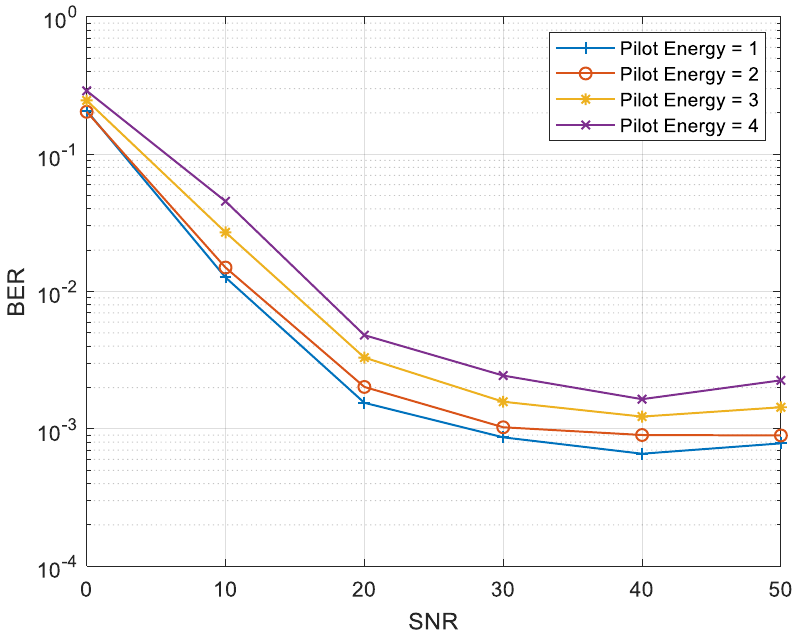
Figure 5. BER as a function of the pilot energies for CP-OFDM with 64 subcarriers, a transmitter- receiver distance of 50 m, and the number of pilots as 16.